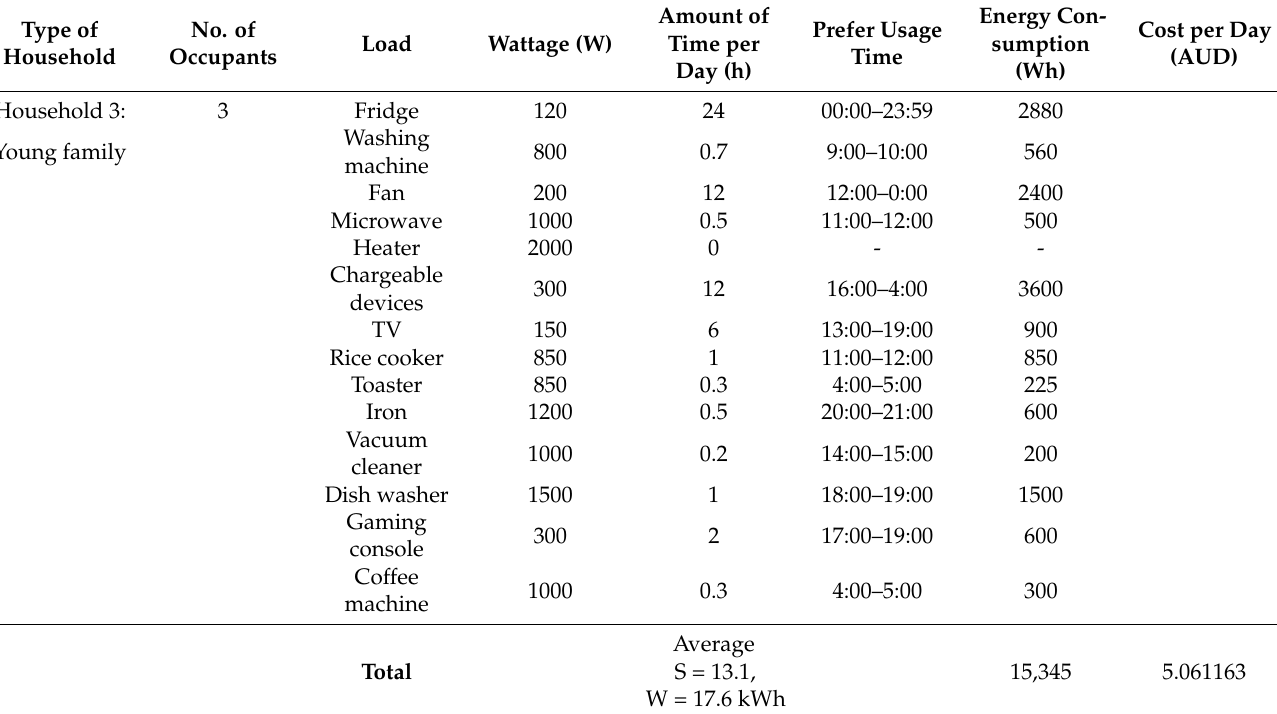
Table 5. Initial load profile 3 created for the project (summer).